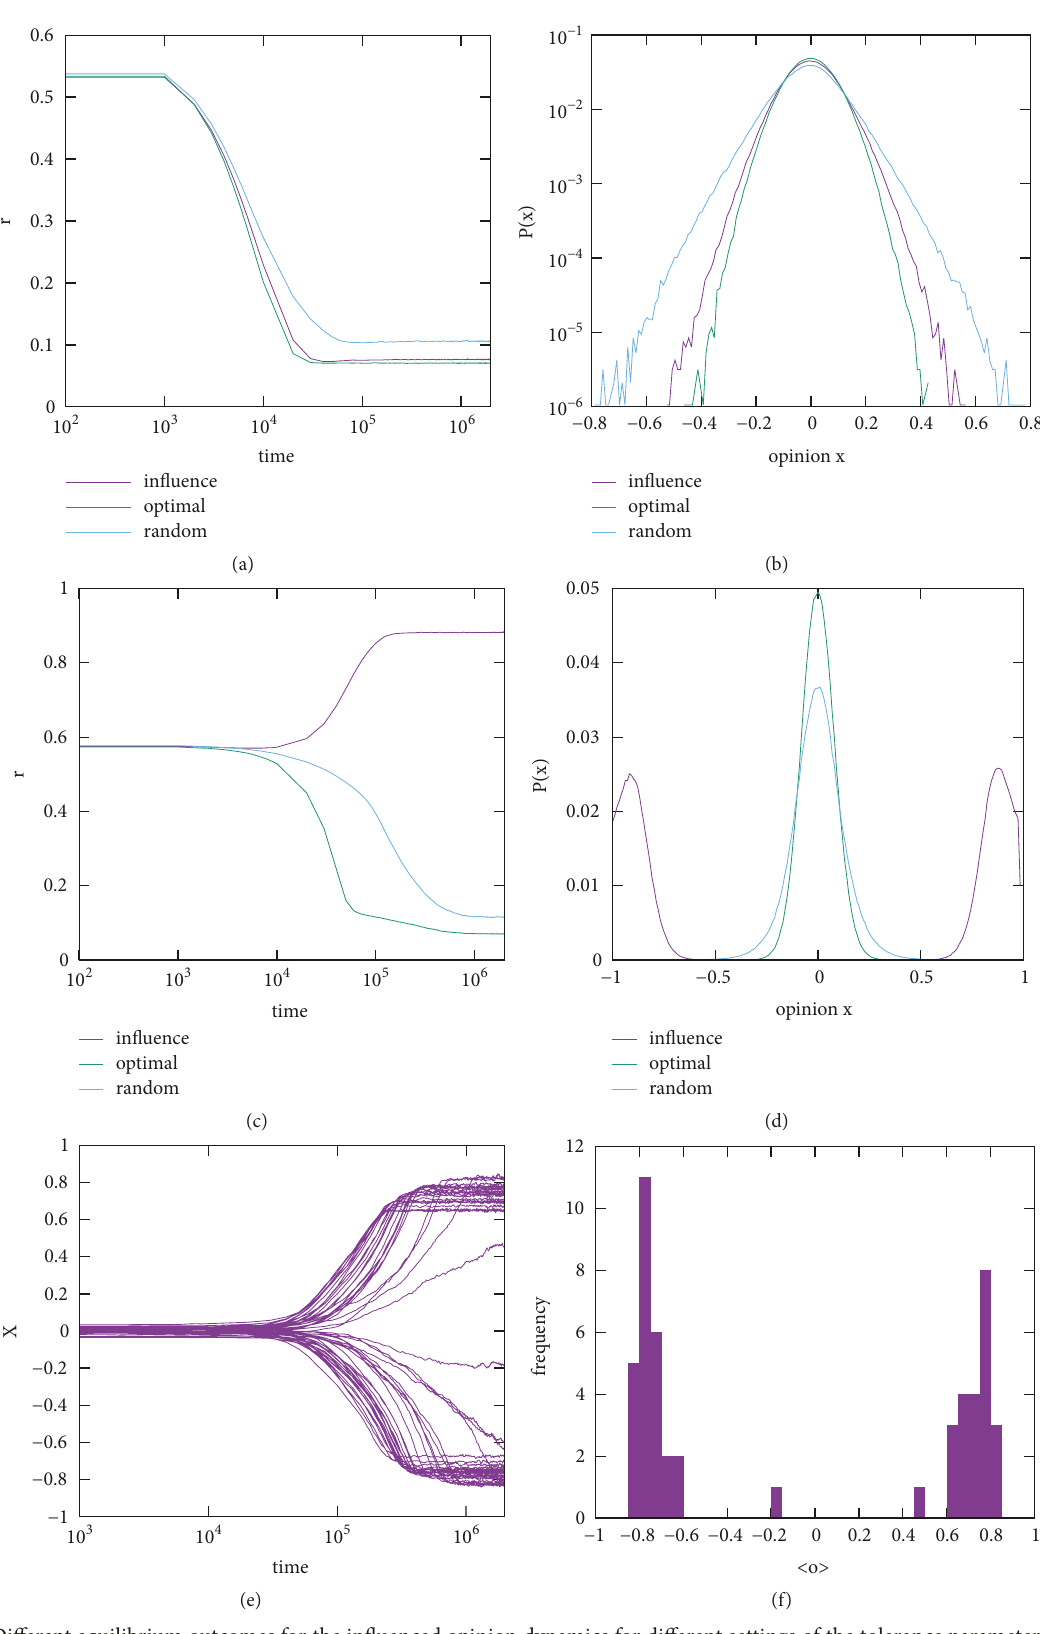
Figure 1: Different equilibrium outcomes for the influenced opinion dynamics for different settings of the tolerance parameter 훿 : ((a), (c)) averagedtimedependenceoftheopiniondispersion 푟 for 훿 = 1.5 and 훿 = 0.5 .((b),(d)):stationarydistributionsoftheopinionsinequilibrium for 훿 = 1.5 and 훿 = 0.5 . The figures compare three different settings for rewiring: competitive influence maximization (influence), rewiring to reduce 푟 (optimal), and random rewiring (random). ((e), (f)): 훿 = 0.75 . (e) Evolution of the average opinion 푋 for various example runs and (f) distribution of the final averaged opinion 푋 . Comparisons to noncompetitive dynamics omitted in (e) and (f). Results are averaged over 50 independent runs for a system of 푁 = 1000 nodes, noise Δ = 0.001 , ⟨푘⟩ = 10 , and 푚 = 1